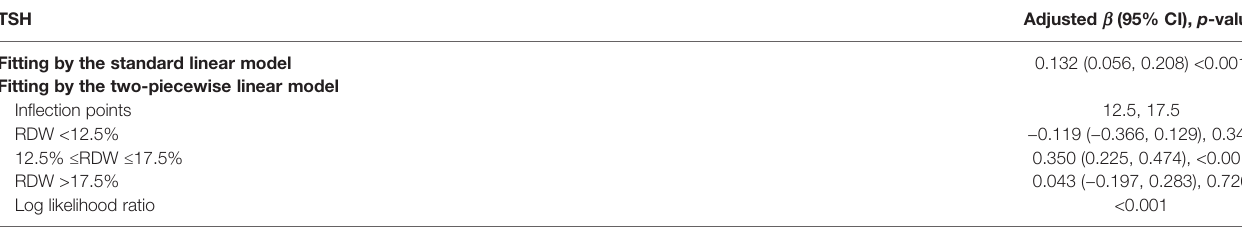
TABLE 3 | Threshold effect analysis of RDW on TSH using the two-piecewise linear regression model. TSH Fitting by the standard linear model